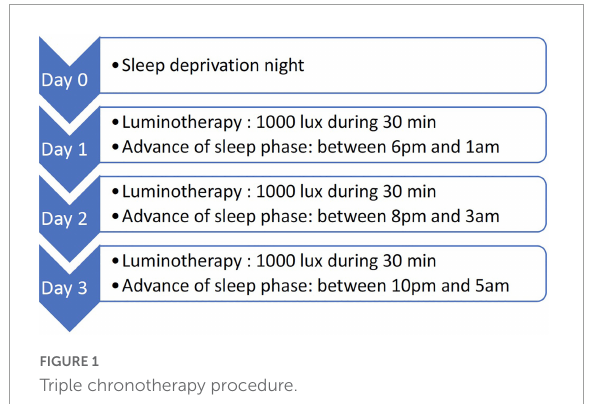
FIGURE1 Triple chronotherapy